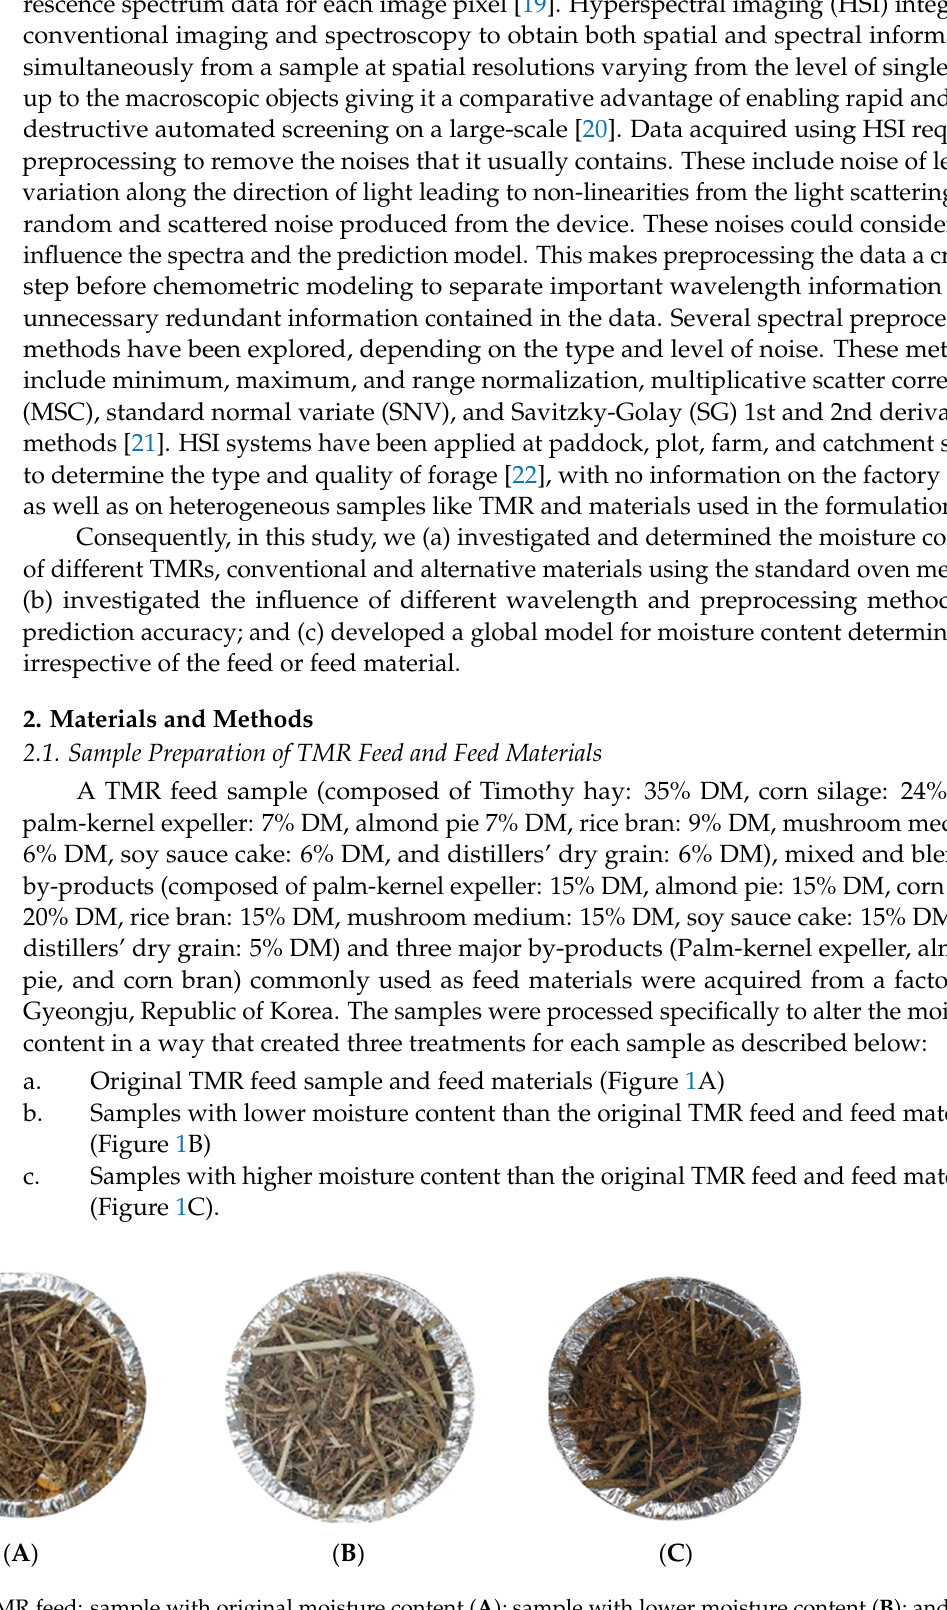
Figure 1. Images of the TMR feed: sample with original moisture content ( A ); sample with lower moisture content ( B ); and sample with higher moisture content ( C ).